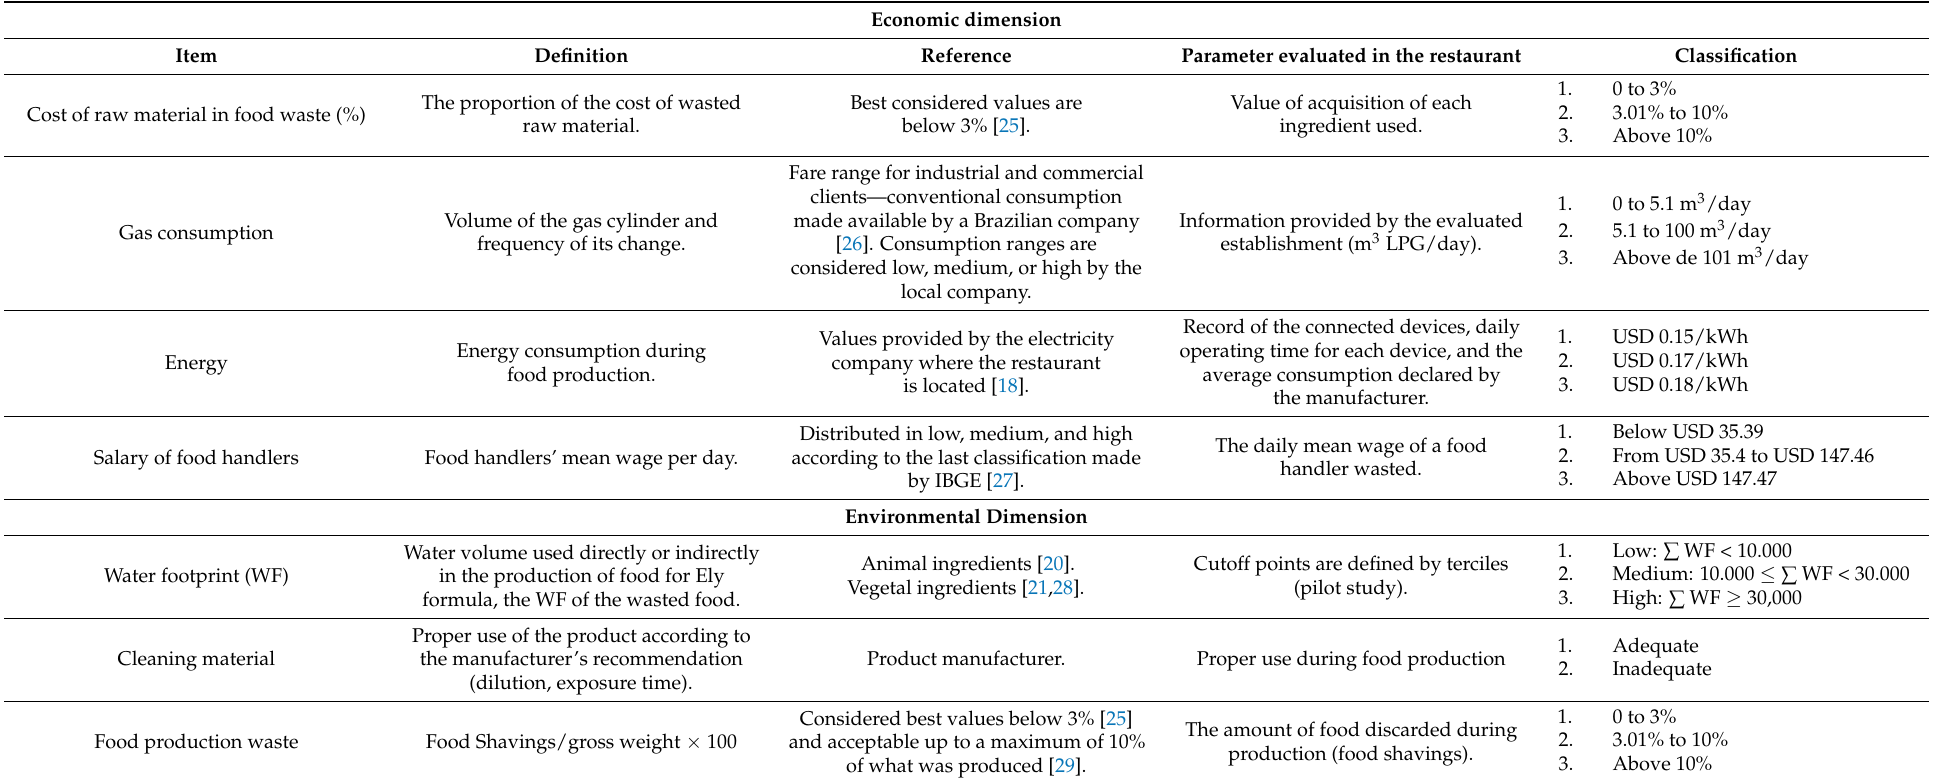
Table 1. Dimensions and parameters for the calculation and classification of eco-inefficiency in